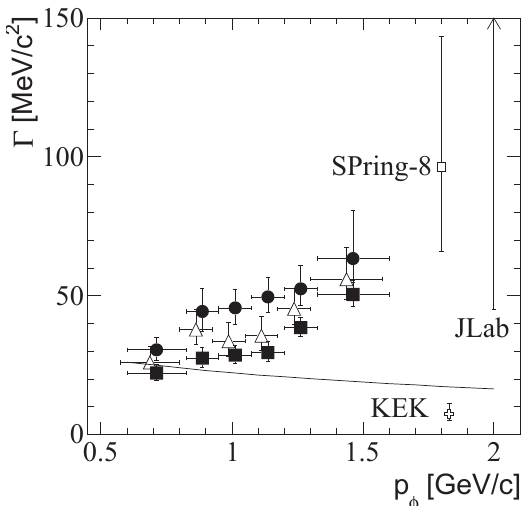
Fig. 5. In-medium φ width in the nuclear rest frame as a function of its momentum (cf. [4]). The points were evaluated by comparing the data of Fig. 4 with model calculations (1 – full squares, 2 – full circles, 3 – open triangles). Also shown are the results from other experiments [22,23,25,26]. The solid line represents the value of Γ φ calculated from the predicted φ self-energy in nuclear matter